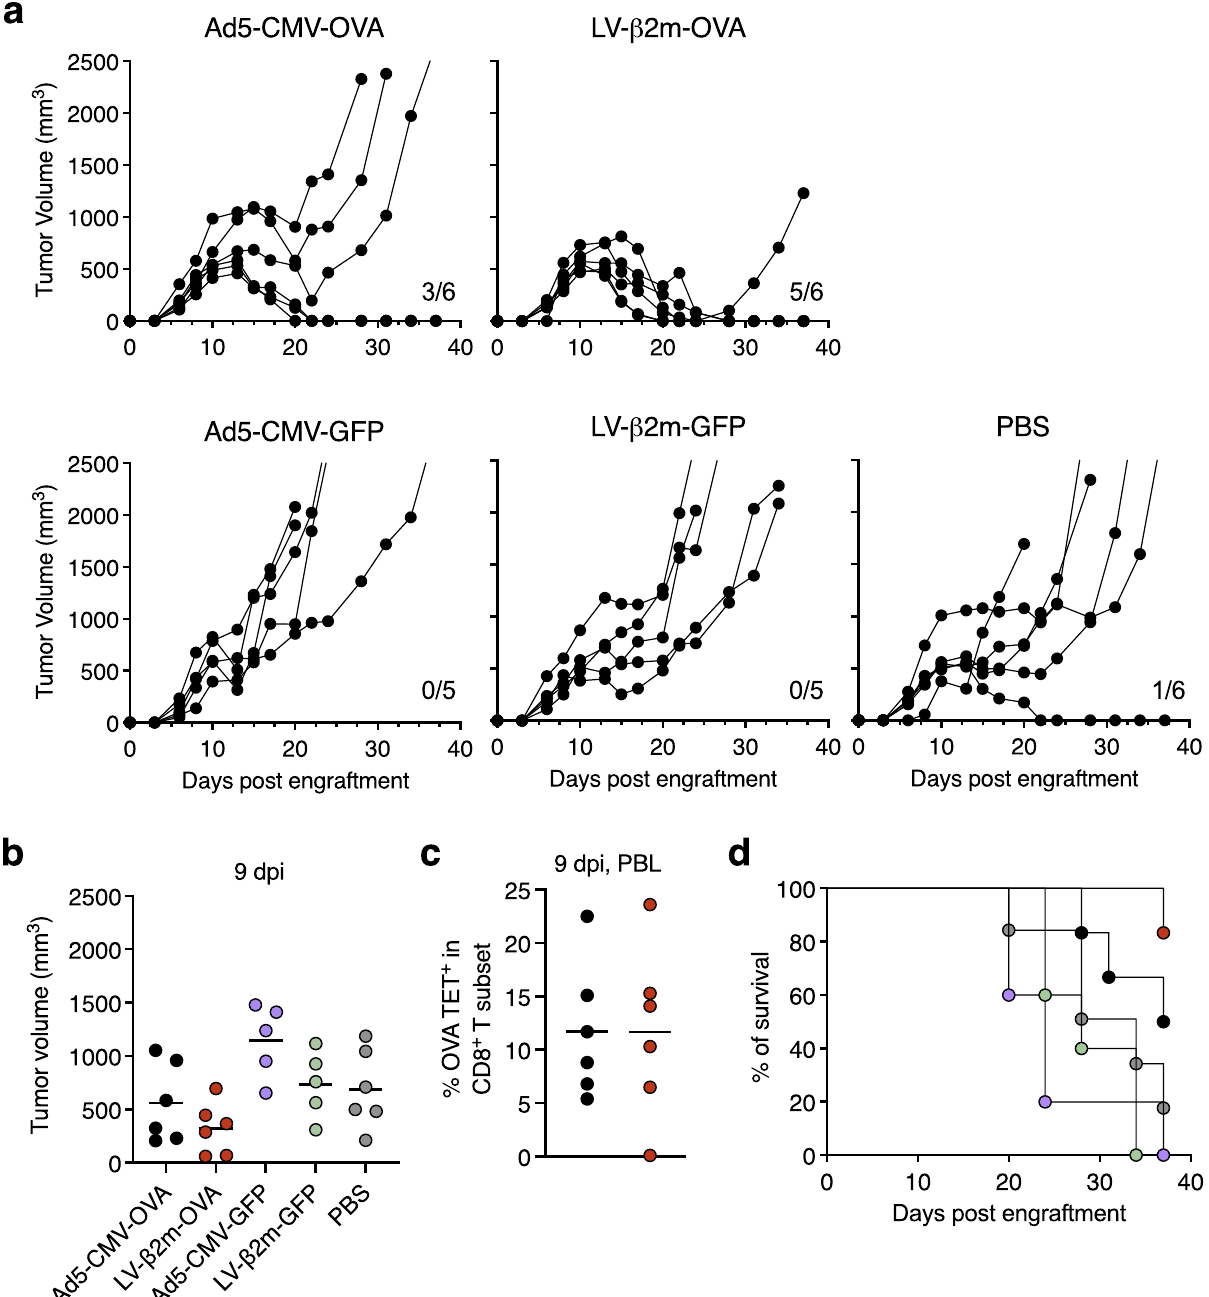
Fig. 7 Superior protection and survival provided by LV- β 2m-OVA therapeutic immunization. C57BL/6 mice ( n = 6 for Ad5-CMV-OVA, LV- β 2m-OVA, and PBS, n = 5 for Ad5-CMV-GFP and LV- β 2m-GFP) were challenged subcutaneously with 3 × 10 6 E.G7 tumor cell line and were immunized with 5 × 10 7 TU of LV- β 2m-OVA or 1 × 10 7 IGU Ad5-CMV-OVA at day 8 post engraftment when tumor volume averaged ~250 mm 3 . a The tumor volume for individual mouse overtime for the indicated immunization. b The tumor volume at 9 dpi (or 17 days post engraftment). c Percentages of antigen-speci fi c T cells within the CD3 + CD8 + T subset in the blood at 9 dpi. For ( b ) and ( c ), black lines represent mean, dots represent biological replicates. d The percentage of survival at the indicated time points is T cells were cultured in DMEM media supplemented with 100 μ g/ml of strepto- relevant peptide mixes. Concanavalin A was used at 2 μ g/ml as T-cell activation mycin, 100IU/ml of penicillin, and 10% heat-inactivated FBS one day before control. Unstimulated cells were also included. After 24h, spots were revealed transduction. Cells were transduced with MOI 10 of lentiviral vector and subjected to according to the manufacturers ’ instructions and counted using an ImmunoSpot S6 fl ow cytometry analysis 3 days after transduction. Mouse bone marrow-derived Ultra-V Analyzer (CTL Europe GmbH, Bonn, Germany). Results were expressed as dendritic cells were prepared from the hematopoietic precursors recovered from spot-forming cells per million of splenocytes and the IFN γ secretion background in femurs of C57BL/6 mice in complete RPMI containing 2% v/v of supernatant of J774 mock-stimulated wells (or negative control peptide) were subtracted. cells stably transfected with murine GM-CSF 69 . Rat bone marrow-derived dendritic cells were prepared from femurs of Sprague Dawley rats and cultured in GM-CSF Evaluation of transduction rate in HEK 293 T cells, mouse bone marrow- (30ng/ml, Peprotech) and IL-4 (5ng/ml, R&D system). After 7 days of culture, 2× 10 6 of a mouse or rat bone marrow-derived dendritic cells were plated per well in 12- derived dendritic cells, and rat bone marrow-derived dendritic cells . HEK 293